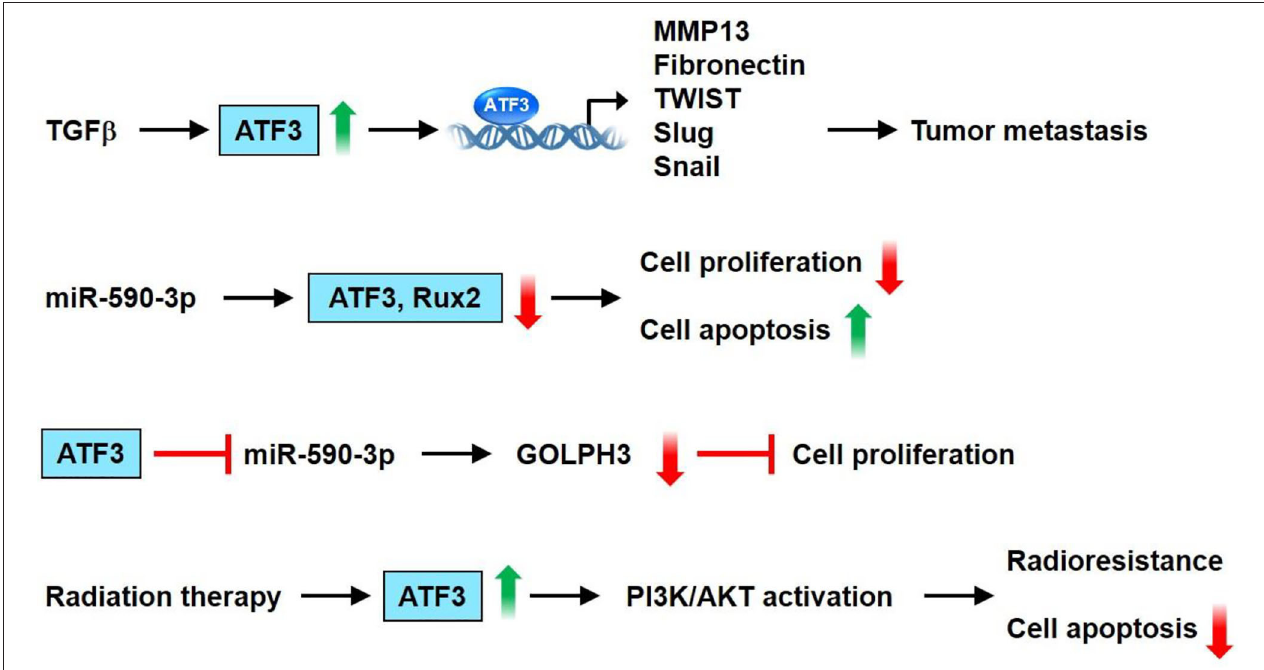
FIGURE 5 | ATF3 plays a vital role in breast cancer. ATF3 expression is increased by TGF β . Furthermore, ATF3 upregulates the expression of some genes involved in tumor metastasis, including MMP13, fibronectin, TWIST1, Slug and Snail in the MCF10CA1a cells. Overexpression of miR-590-3p decreased cell proliferation and increased apoptosis via downregulation of the expression of ATF3 and Runx2 in MDA-MB231 cells. In addition, ATF-3 inhibits miR-590-3p expression to regulate miR-590/GOLPH3 pathway, and thus modulates proliferation of breast cancer cells. ATF3 was shown to be involved in radioresistance of breast cancer via PI3K/AKT signaling pathway. These observations show that ATF3 acts as an important regulator in breast